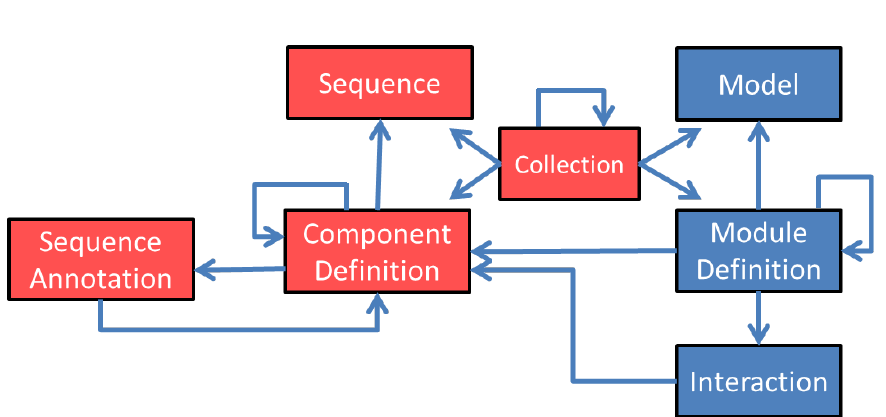
Figure 2: Main classes of information represented by the SBOL standard, and their relationships. Red boxes are classes from the SBOL 1.1 that focused on structure, whereas blue classes are some of the new classes that support the functional aspects of designs.